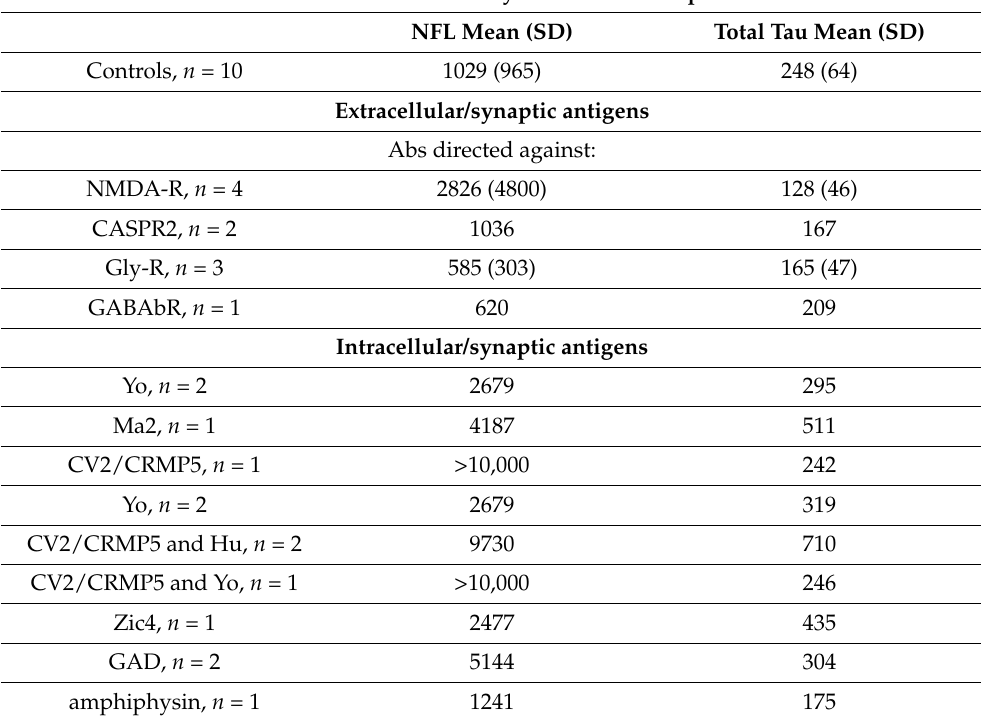
Table 2. CSF NFL and CSF total tau levels (pg/mL) in patients with various encephalitis syndromes associated with antibodies directed against either extracellular or intracellular/synaptic antigens. CSF Biomarkers in Antibody-Associated Encephalitis NFL Mean (SD) Total Tau Mean (SD) Controls, n = 10 1029 (965) 248